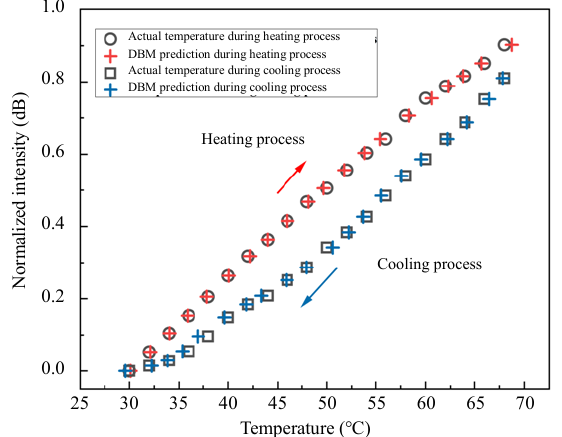
Fig. 7 Prediction skills of DBN for temperature forecasting in increasing and decreasing sensing processes. The structure parameters of the HMF sensor are d =11.0 μm, S =3.94 mm, θ =13.45°, and N